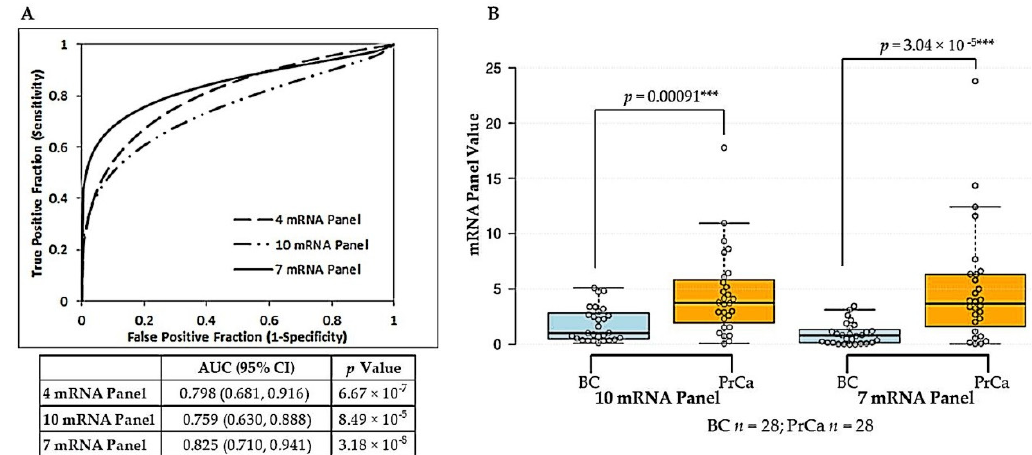
Figure 2. Comparison of Vn96-isolated EV reference-free mRNA panels for prostate cancer discrimination: derivation of seven mRNA panel. ( A ) ROC curve analysis showing discrimination of Prostate Cancer (PrCa; n = 28) from Benign Control (BC; n = 28) using either the previously optimized four mRNA panel, the 10 mRNAs (four mRNAs from panel plus six mRNAs sourced from literature) as a combined panel, or the final optimized seven-member mRNA panel. AUC, 95% CI and p value for each reference-free mRNA panel are provided below the plot. ( B ) Box plot graphically depicting results for the 10 mRNA and the optimized seven mRNA panels obtained for Benign Control (BC) versus Prostate Cancer (PrCa) groups using Vn96-isolated EV RNA. Details of plot are as described for Figure 1. p values were obtained using the Mann-Whitney U test to compare differences. Differences denoted by asterisks are statistically significant (* p < 0.05, ** p < 0.01, and *** p < 0.001). The final seven mRNA panel was calculated as the ratio of expression of four mRNAs overexpressed in prostate cancer ( FOLH1 , HPN, CD24, TMPRSS2-ERG ) to three mRNAs underexpressed in prostate cancer ( ITSN1, ANXA3, SLC45A3 ).